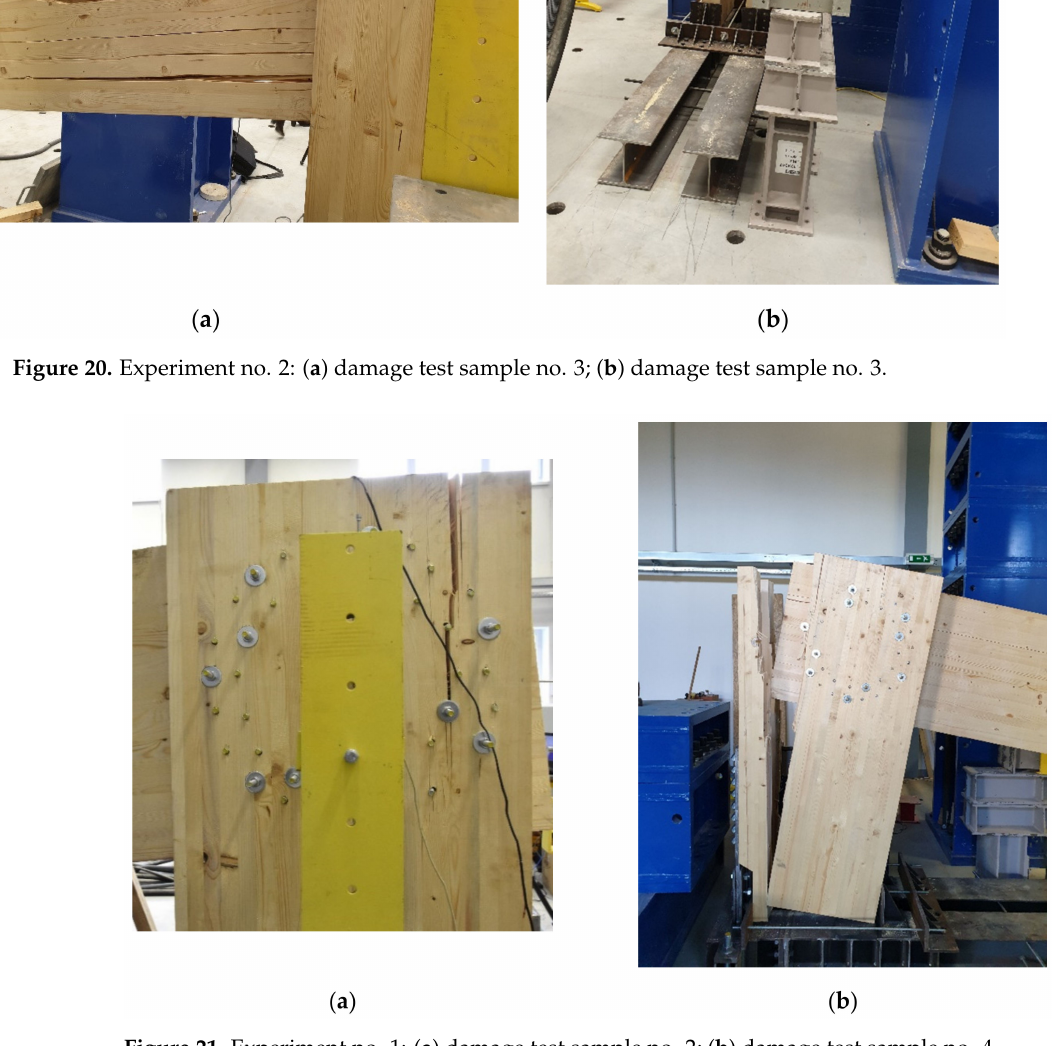
Figure 21. Experiment no. 1: ( a ) damage test sample no. 2; ( b ) damage test sample no.